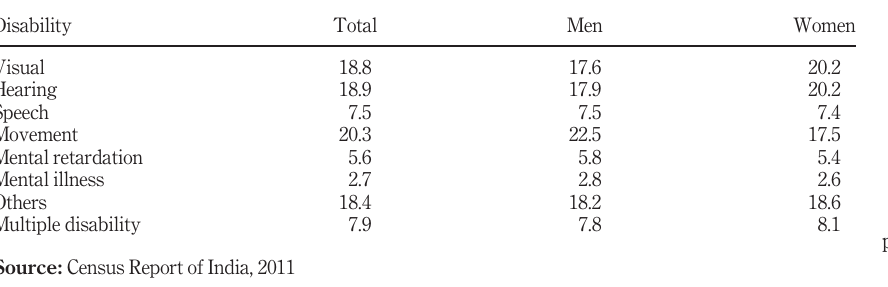
Table II. India ’ s